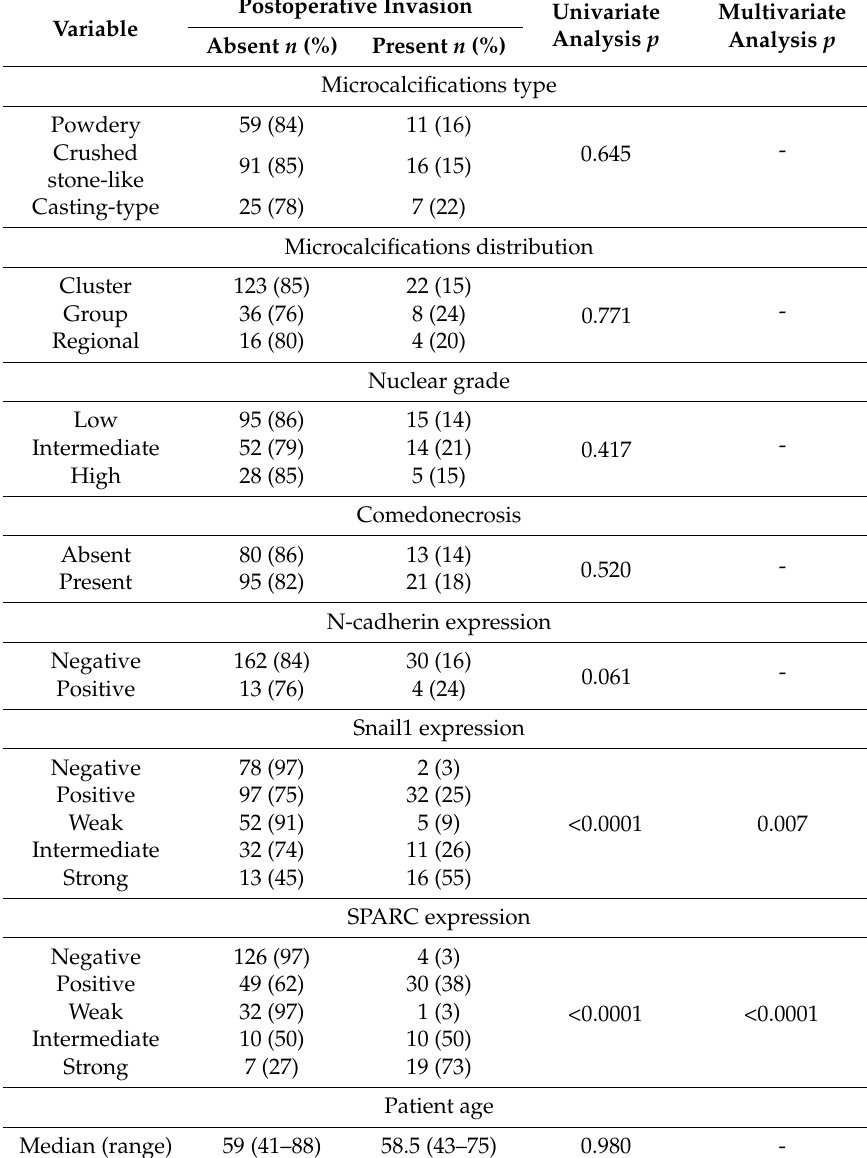
Table 3. Association between preoperative features and final invasion on surgical specimens.